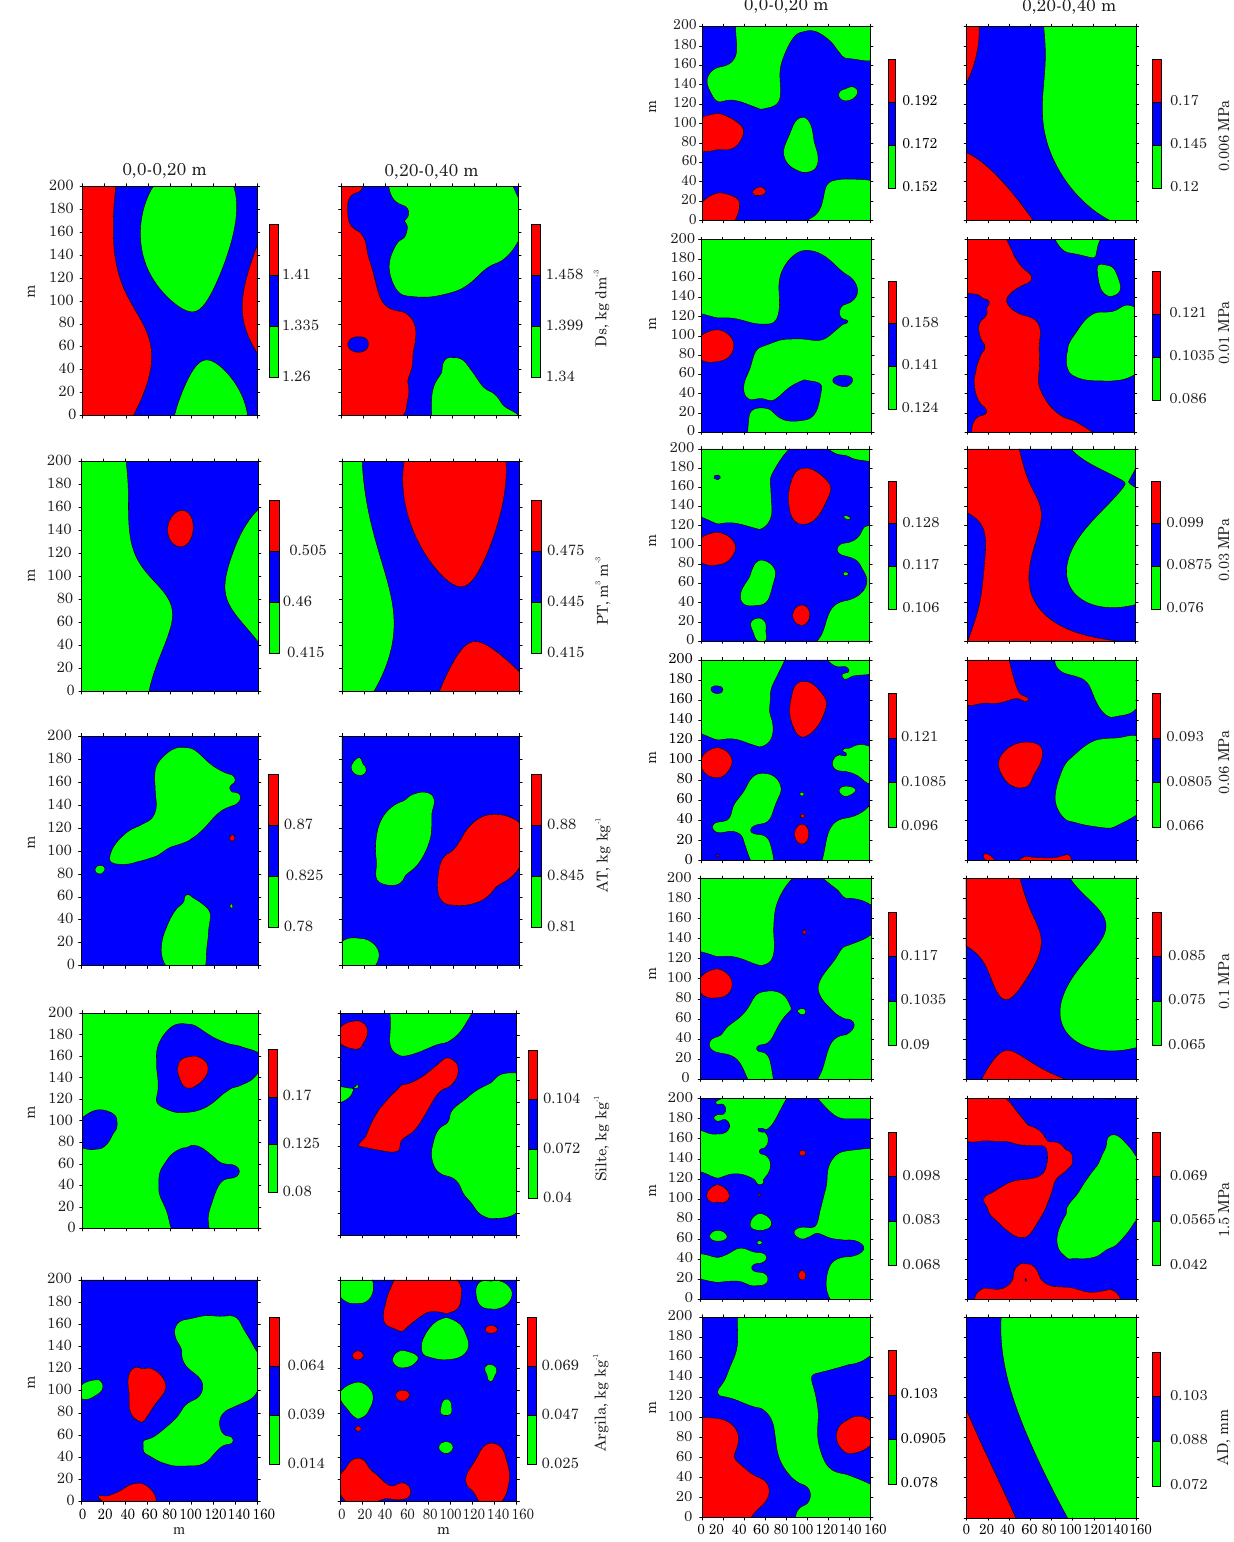
Figura 4. Mapas de zonas homogêneas da densidade do solo (Ds), porosidade total (PT), areia total (AT), silte e argila, na área experimental.